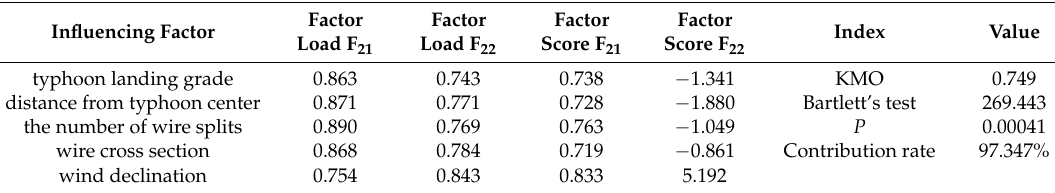
Table 3. Factor analysis of wind strength.